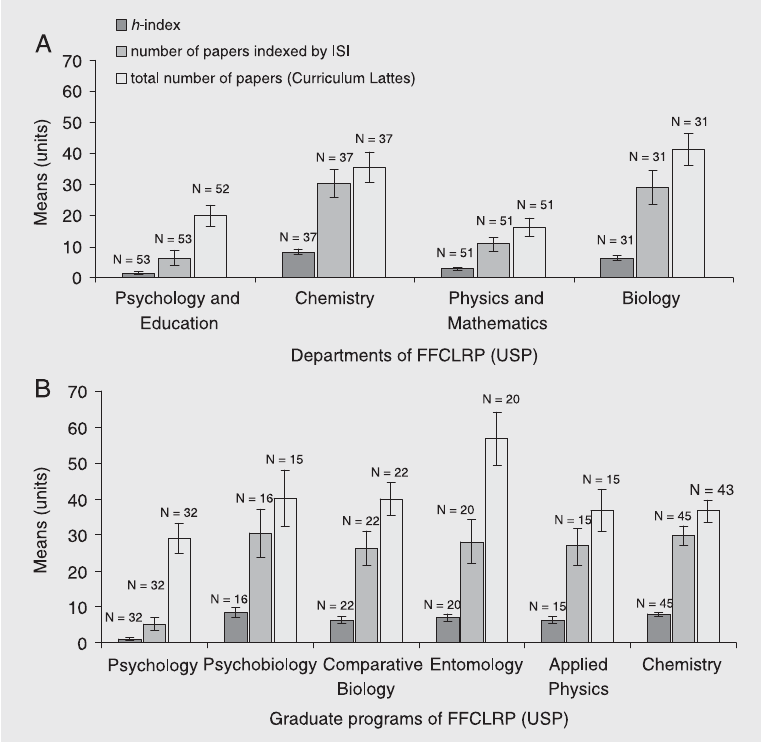
Figure 1 . Means and standard errors of h -index values, number of papers indexed by the Thompson ISI Web of Science, and total number of papers in the Curriculum Lattes of